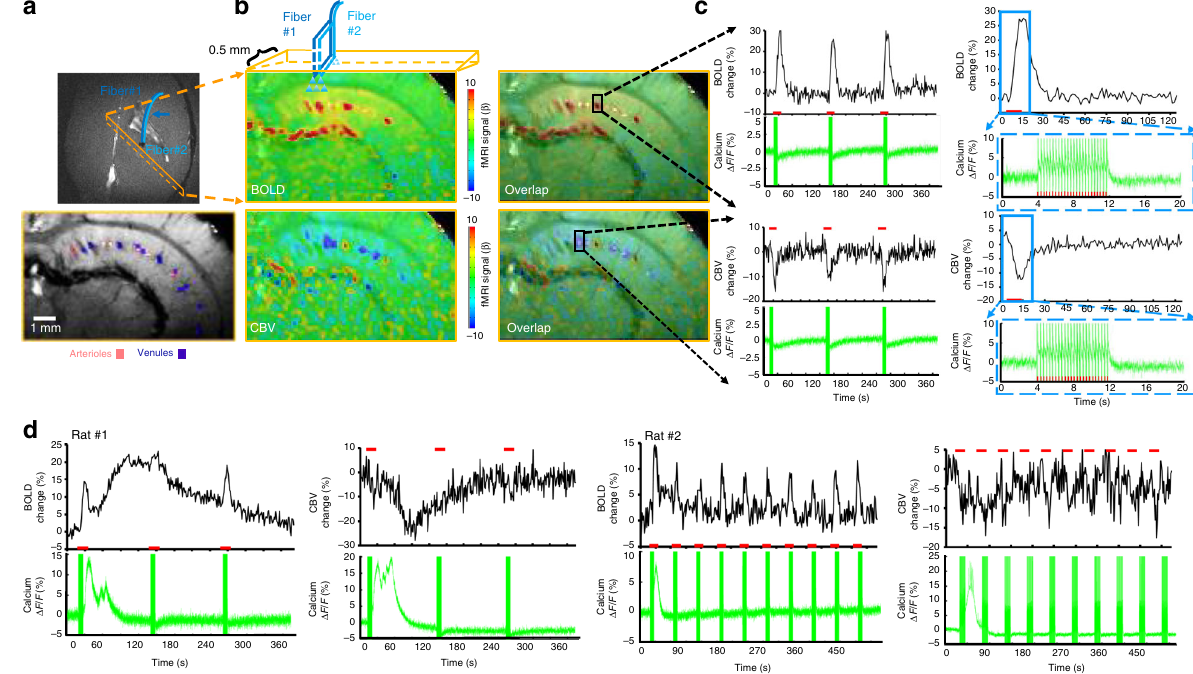
Fig. 3 Concurrent fMRI and Ca 2 + recording in the hippocampus. a Schematic drawing of the hippocampal single-vessel fMRI with two optical fi bers (blue arrow) for optogenetic stimulation and Ca 2 + recordings. A representative A – V map shows individual arterioles (bright dots, red markers) and venules (dark dots, purple markers) on the same 2D slice. b Evoked BOLD (upper) and CBV-weighted (lower) fMRI maps and overlapping maps on the A – V map. c Time courses of evoked BOLD and CBV-weighted fMRI signal from a single venule (upper) or arteriole (lower) ROI with the concurrent neuronal Ca 2 + signal (illumination: 10 ms light pulse, 3 Hz, 8 s, 5 mW). Averaged time course of the fMRI signal and the evoked Ca 2 + spike train. d A representative time course of single-vessel BOLD and CBV-weighted fMRI signal changes with concurrent hippocampus SDL-Ca 2 + responses (illumination: 10 ms light pulse, 3 Hz, 8 s, 5